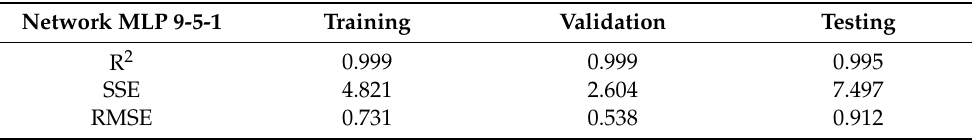
Table 3. Results of teaching, validation, and testing for the prediction with MLP